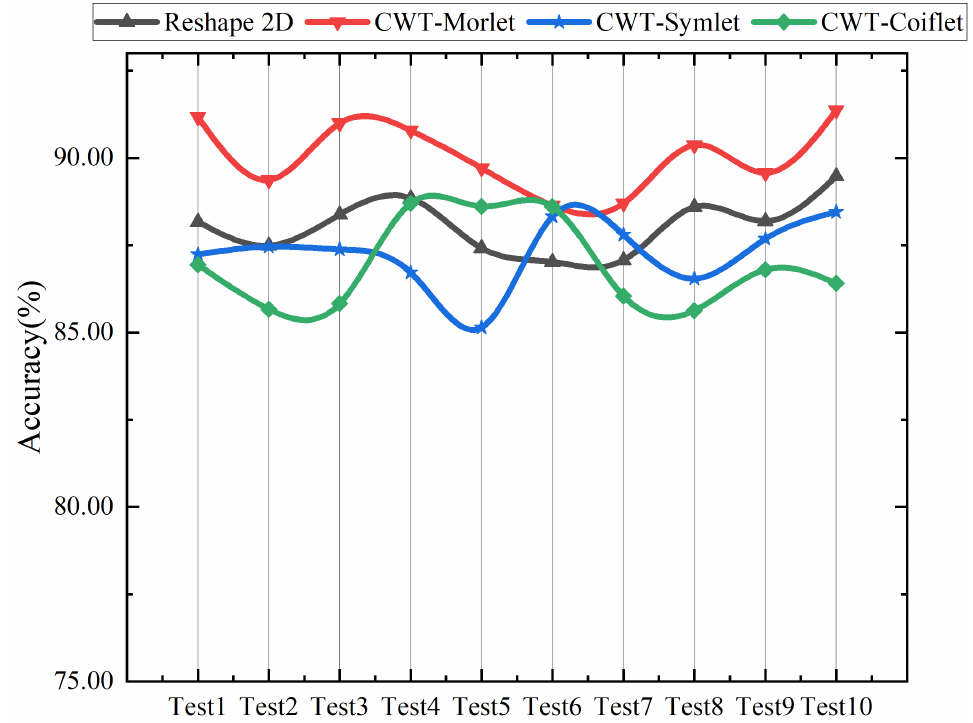
Figure 7. Detailed experimental results under different pre-processing